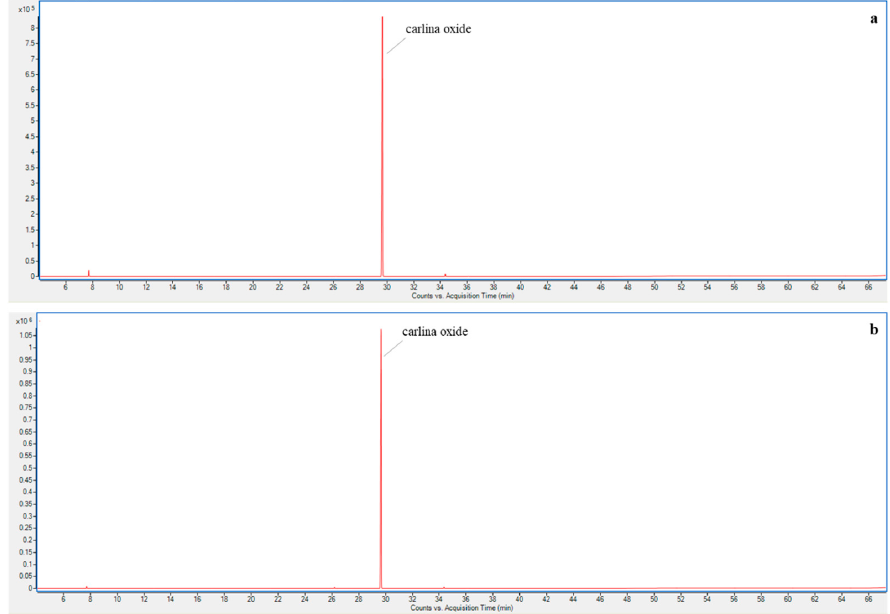
Figure 6. GC-MS chromatograms of HD ( a ) and MAH ( b ) Carlina acaulis essential oils.